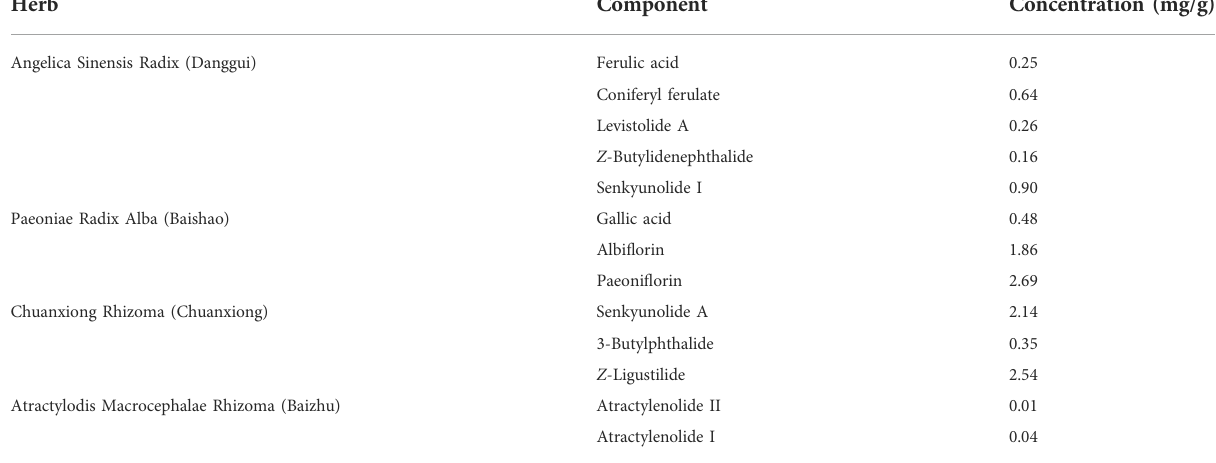
TABLE 1 Information on the chemical analysis of DSS from the literature. DSS, Danggui-Shaoyao-San. Herb